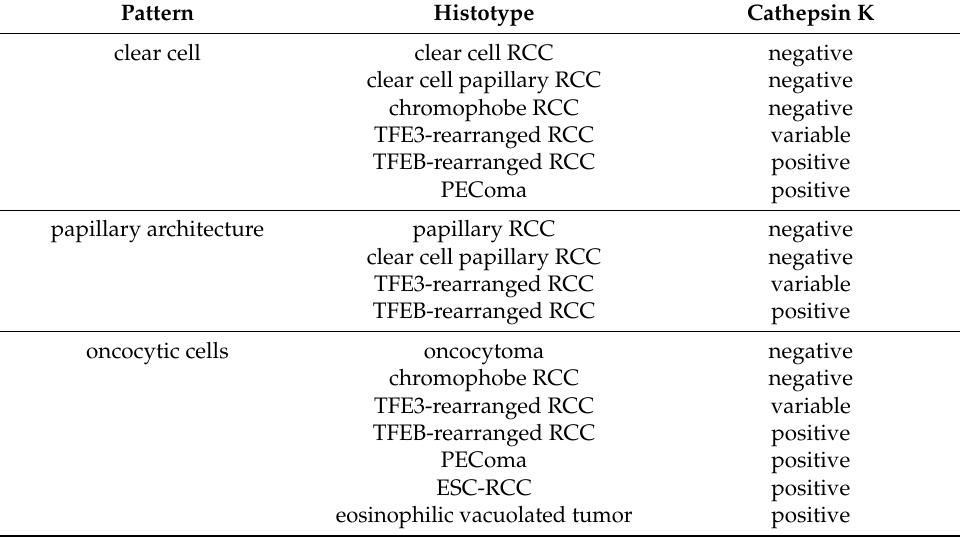
Table 3. Cathepsin k in differential diagnosis among renal